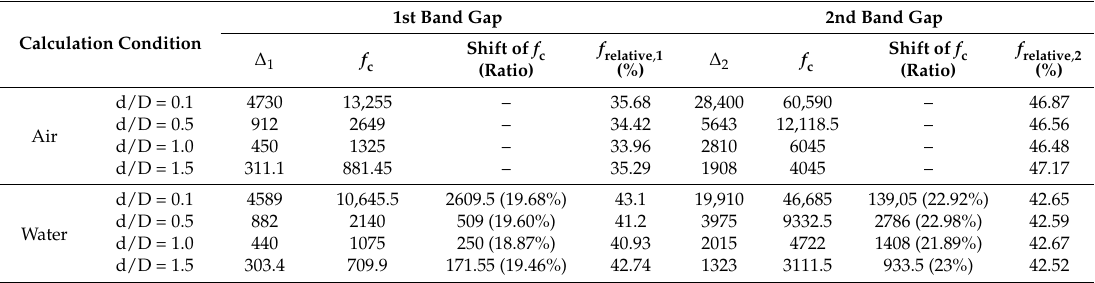
Table 1. The relationships between the related band-gap parameters and the dimensions of the immersed PC beam obtained from the band structure calculated by the SEM. a